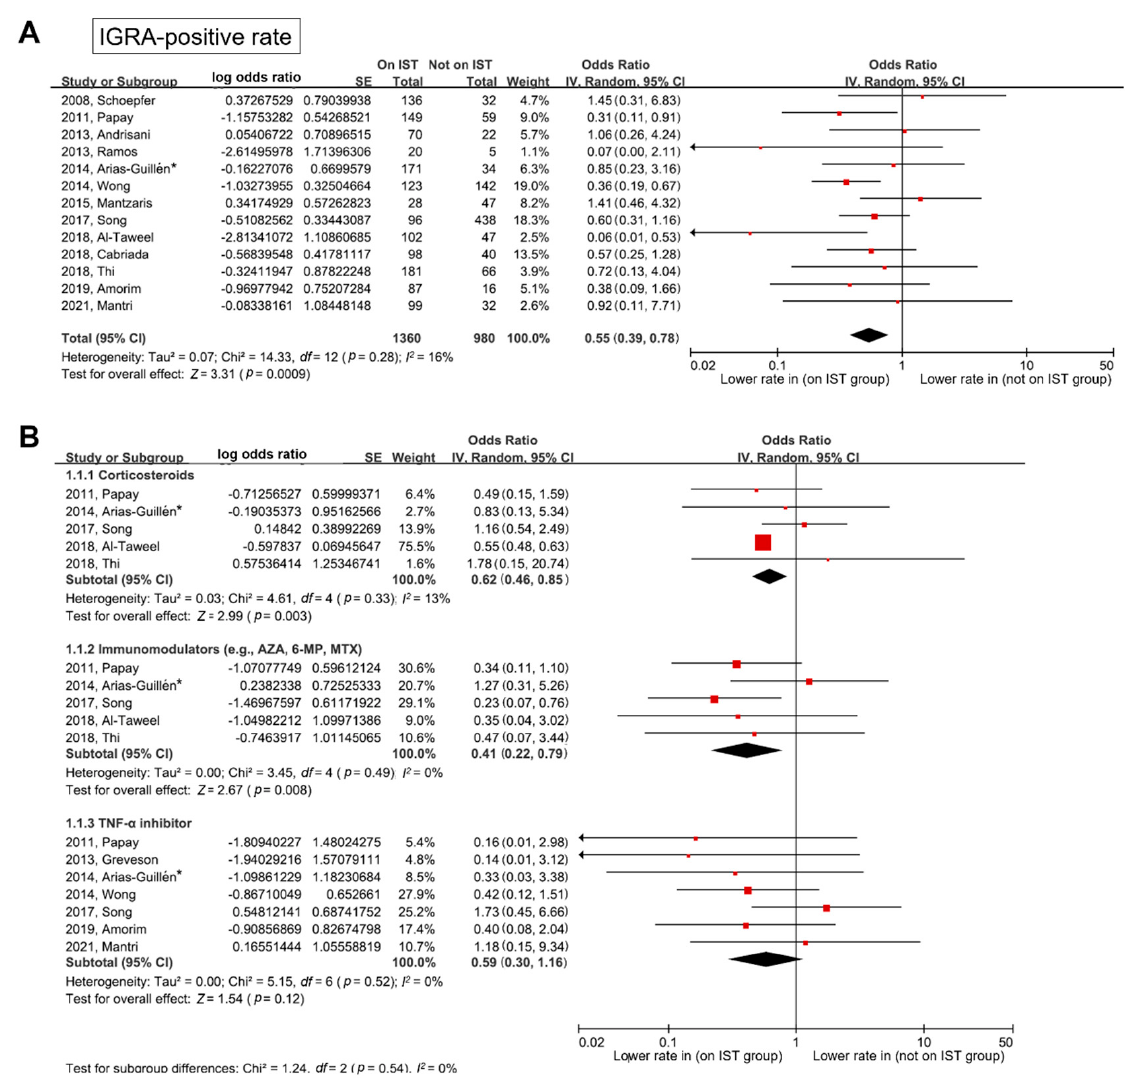
Figure 2. Forest plot for IGRA-positive rate between patients on IST and those not on IST. ( A ) Any IST, and ( B ) subgroup analysis according to IST. * In this study, both QFT and T-SPOT were performed. QFT data were included in the meta-analysis. IGRA—interferon γ release assay; IST— immunosuppressive treatment; QFT—QuantiFERON-TB Gold In-Tube test; T-SPOT—T-SPOT.TB test; AZA—azathioprine; 6-MP—6-mercaptopurine; MTX—methotrexate; TNF—tumor necrosis factor; SE—standard error; IV—inverse variance; CI—confidence interval; df —degrees of freedom.